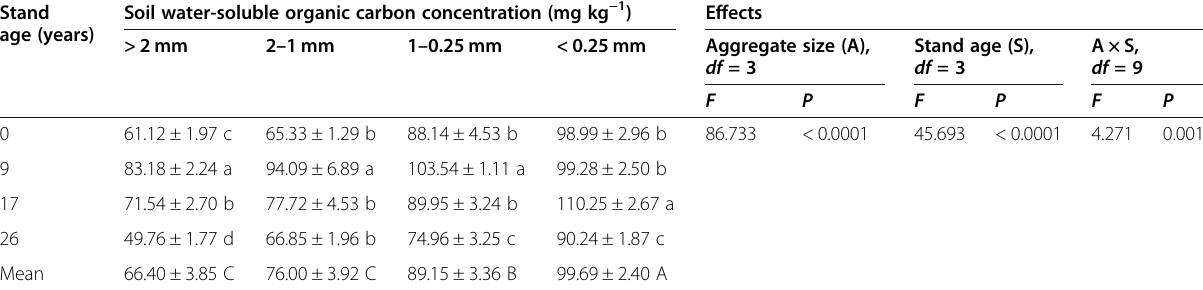
Table 7 Effects of aggregate sizes (> 2, 2 – 1, 1 – 0.25, and < 0.25 mm) and stand ages (0 years, 9, 17, and 26 years) on the soil water- soluble organic carbon concentration in a chronosequence of Chinese fir plantations Stand Soil water-soluble organic carbon concentration (mg kg − 1 age (years)